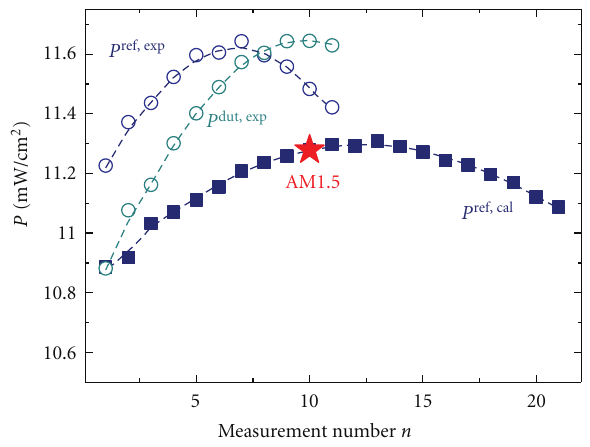
F 7: e converted power was determined in ments under the sun simulator illumination applying additional LED illumination. e reference tandem solar cell was measured under an attenuated sun simulator spectrum (�lled blue symbols) and under a noncalibrated illumination (open blue symbols). e device under test was characterized under the same test spectra (open cyan symbols). e measurement number differentstepsinadditionalLEDbiasillumination.Weshow11steps for the experiment, 21 in the calibration. e red star marks the illumination conditions closest to